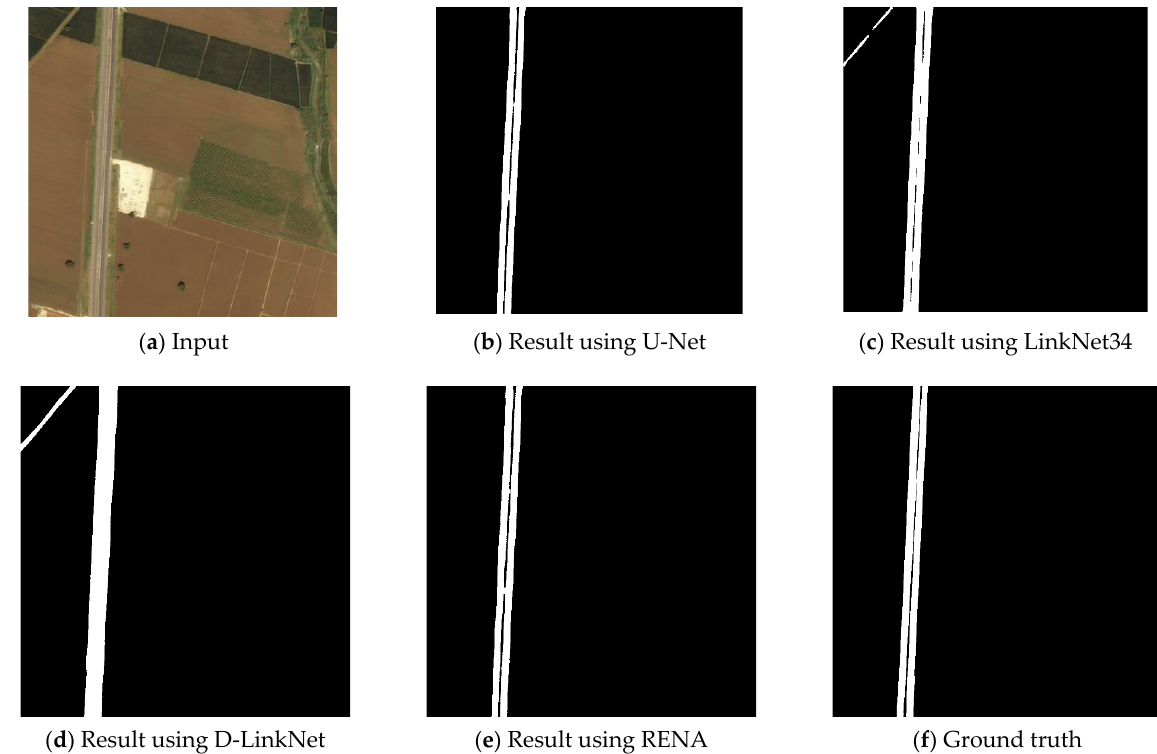
Figure 10. Visual evaluation results of the second group of sparse road networks.